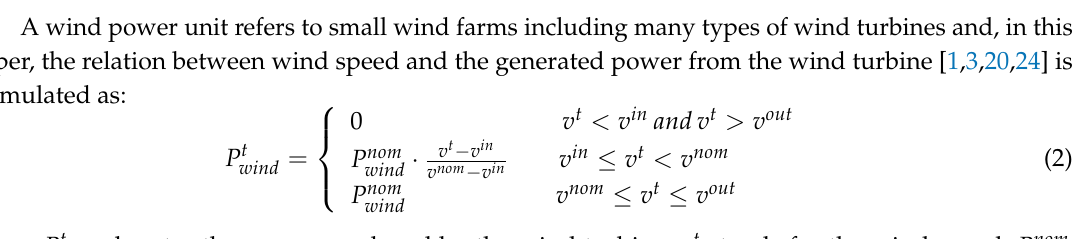
Figure 2. Example of energy hub (EH) in an integrated energy system (IES).